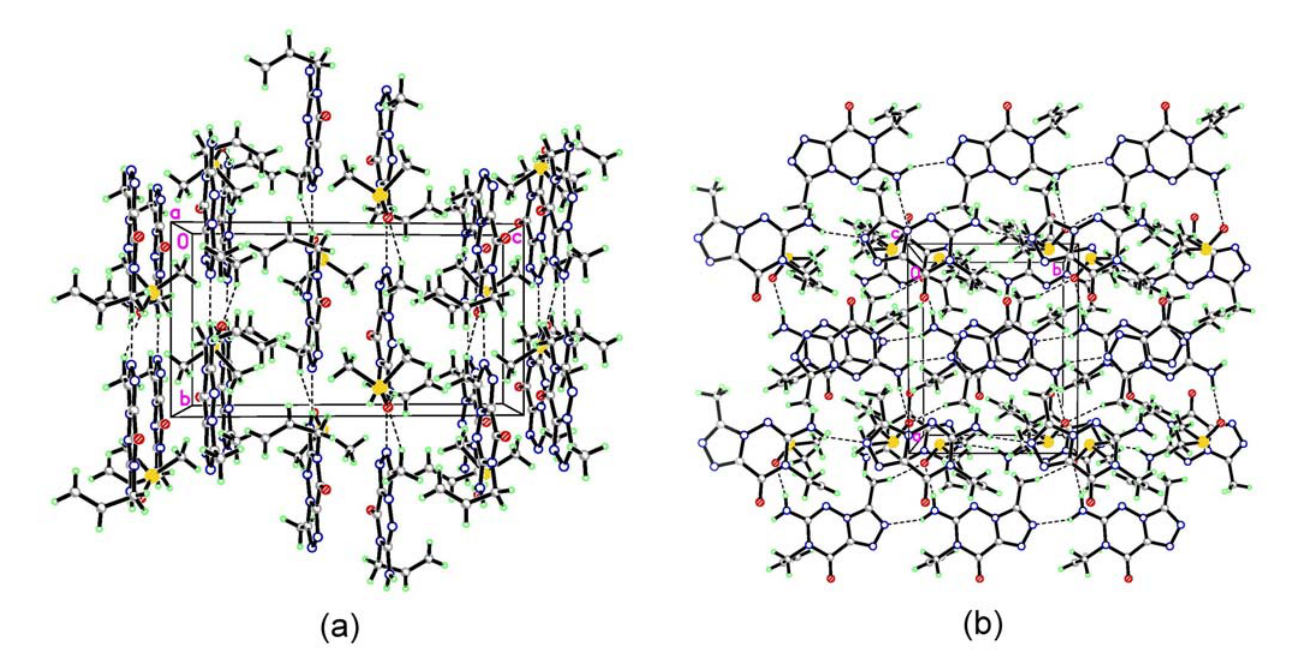
Figure 2. A perspective drawing of the packing arrangement of molecule 3 , showing (a) the molecules’ direction along the a -view and (b) c -view with π - π stacking interactions. Dashed lines are intermolecular N − H···O hydrogen